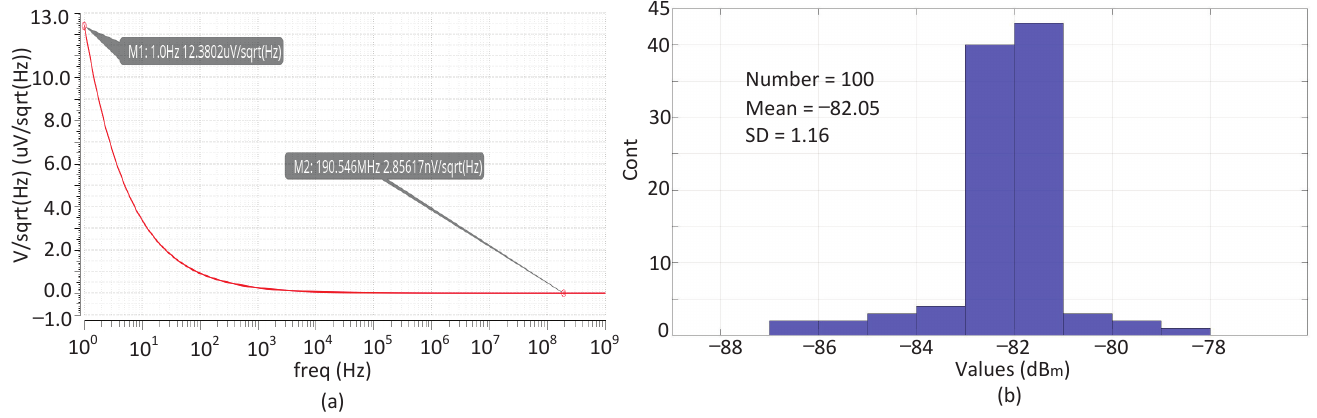
Figure 8. ( a ) Equivalent input noise of spur detection circuit, ( b ) Results of Monte-Carlo simulation for detection accuracy.